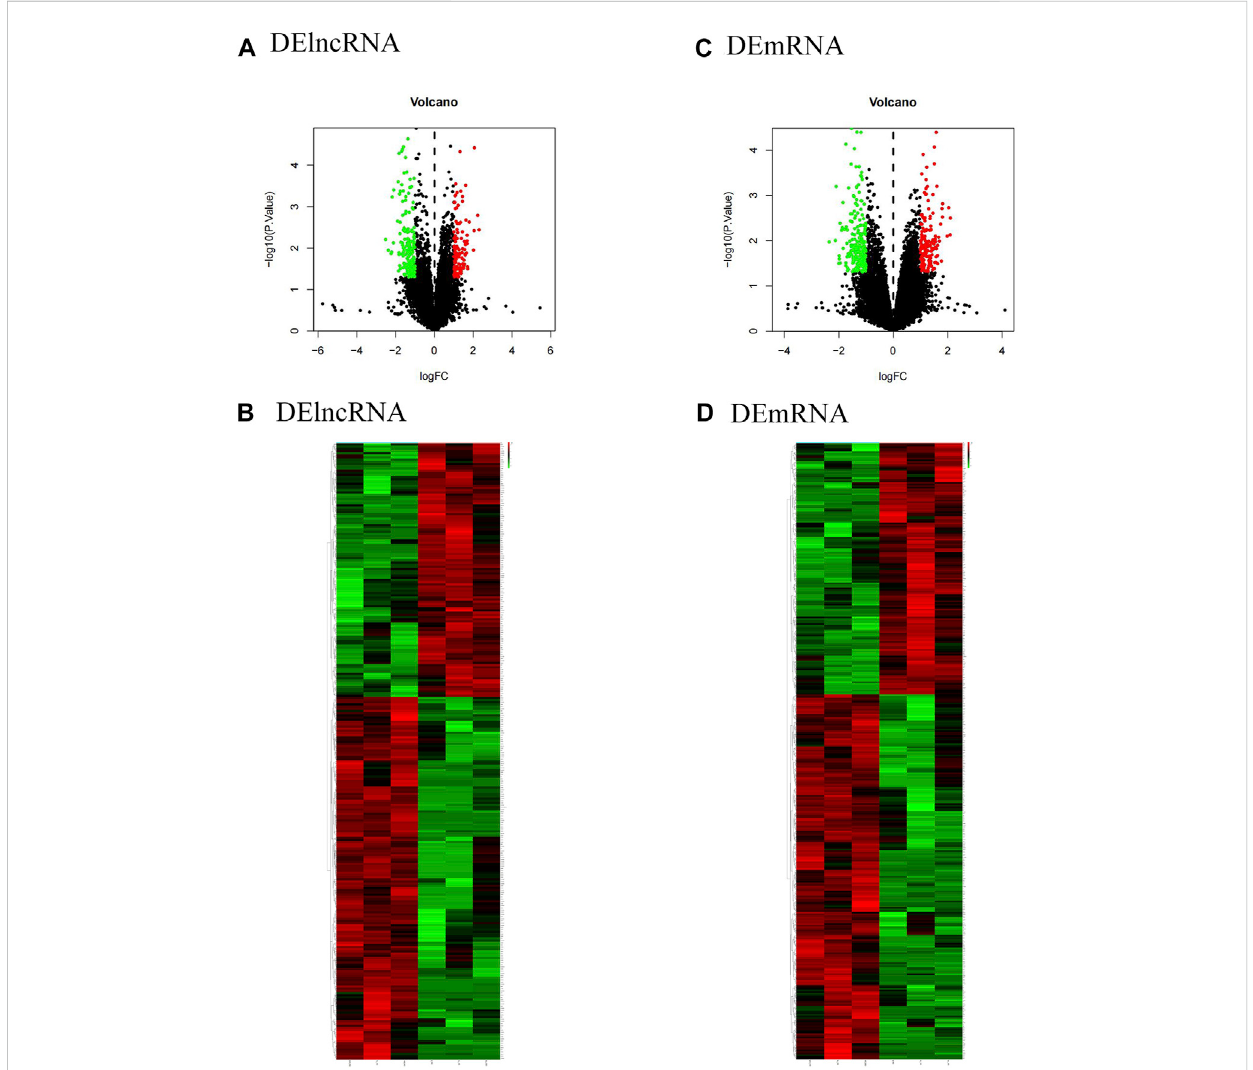
FIGURE 1 Expression analysis of DElncRNA and DEmRNA in the training cohort (volcano map and cluster heat map). (A) and (C) show the volcano plots of DElncRNA and DEmRNA, respectively. Red dots represent upregulated expression, and blue dots represent downregulated expression; (B) and (D) represent the clustering heatmaps of DElncRNA and DEmRNA, respectively. Red stripes show upregulated expression, while blue stripes show downregulated expression. DElncRNA: differentially expressed lncRNA; DEmRNA: differentially expressed